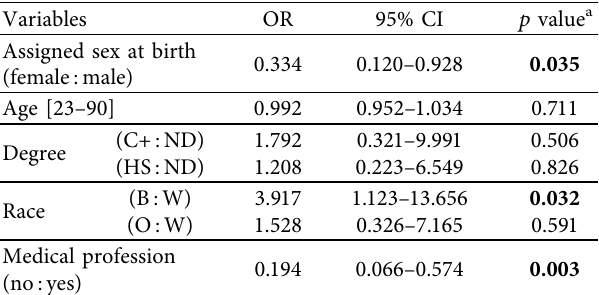
Table 6: Relationship between patient’s demographics and their satisfaction of the procedure, with the propensity to predict poor satisfaction with the